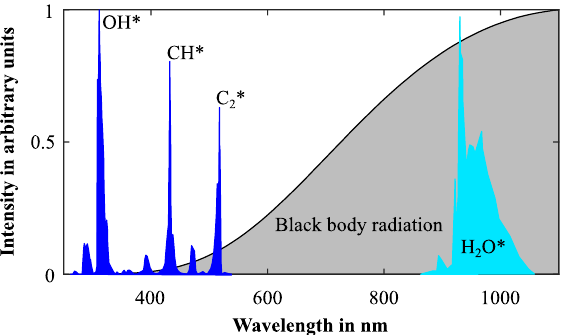
Figure 1. Intensity spectra of methane combustion (data taken from [20 –